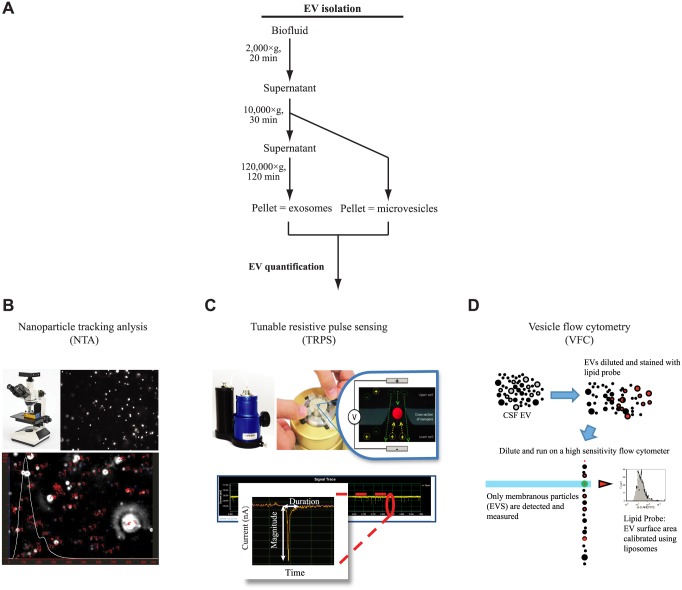
EV quantitative analysis.(A) Schematic representation of protocol used for the isolation of CSF microvesicles and exosomes. (B) In nanoparticles tracking analysis, light scattered by EVs is captured by digital camera over a series of frames. The rate of the particle movement is then used to calculate particle size using the Stokes—Einstein equation. (C) In tunable resistive pulse sensing, EVs change the electrical resistance as they pass through a pore-based sensor resulting in a resistive pulse signal. Signals obtained from the measurements can then be used to calculate the size, concentration and charge of each particle by correlating the signal back to a set of known standards. (D) In Vesicle flow cytometry, EVs were stained with an optimized concentration of a fluorogenic lipophilic probe, di-8-ANEPPS, and detected on a custom high sensitivity flow cytometer. Vesicle diameter was estimated by comparison to di-8-stained liposomes.